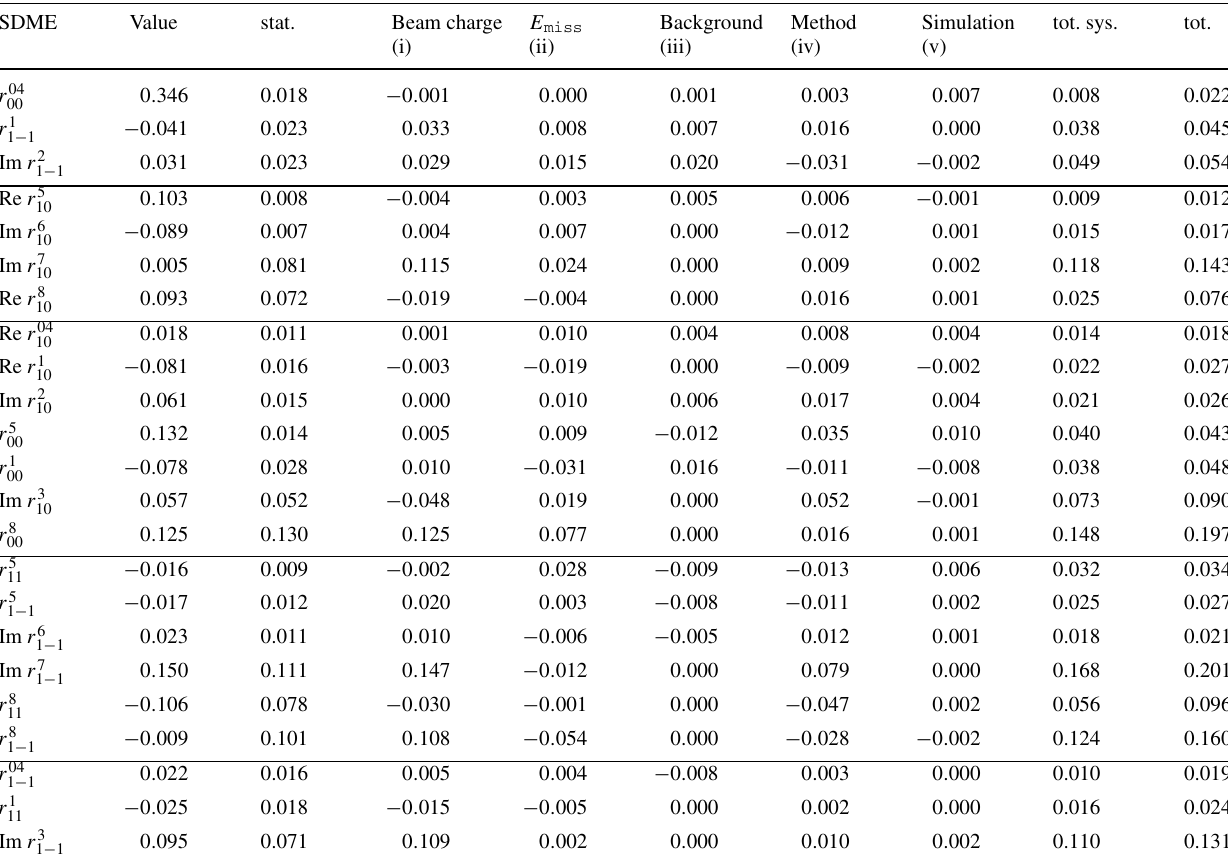
Table 4 Uncertainties for each SDME value: in column 3 the statistical uncertainty (“stat.”), in columns 4–8 the individual contributions for each source of systematic uncertainty as defined in Sect. 5.3, in column 9 the total systematic uncertainty (“tot. sys.”), and in column 10 the total uncertainty